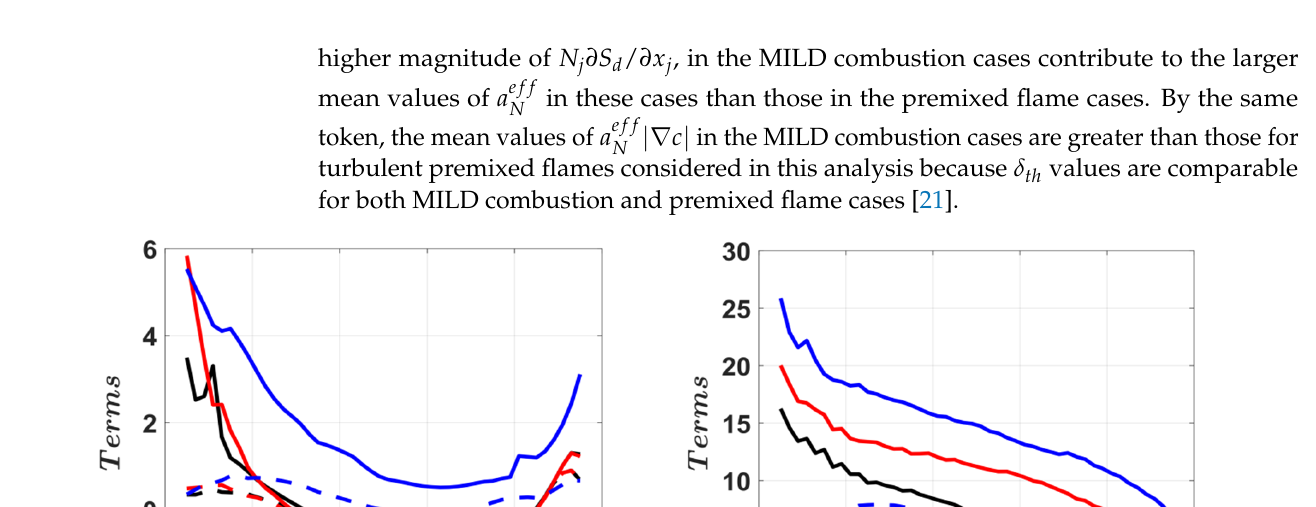
Figure 12. Profiles of the normalised mean values of the effective normal strain rate ( (cid:1853) (cid:3015)(cid:3032)(cid:3033)(cid:3033) × (cid:2012) (cid:3047)(cid:3035) / (cid:1845) (cid:3013) ) and (cid:1853) (cid:3015)(cid:3032)(cid:3033)(cid:3033) |∇(cid:1855)| × (cid:2012) (cid:3047)(cid:3035)(cid:2870) / (cid:1845) (cid:3013) conditioned upon (cid:1855) for (cid:1873) (cid:4593) (cid:1845) (cid:3013) ⁄ = 4.0 (black) 6.0 (red) and 8.0 (blue) for statistically planar turbulent premixed flames (first column) and homogeneous MILD combustion cases (second column). Note the difference in scales between the premixed flame and MILD combustion cases.